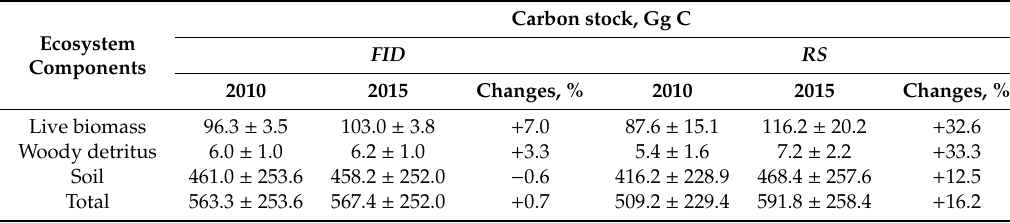
Table 11. Stock-based C changes, 2010–2015.